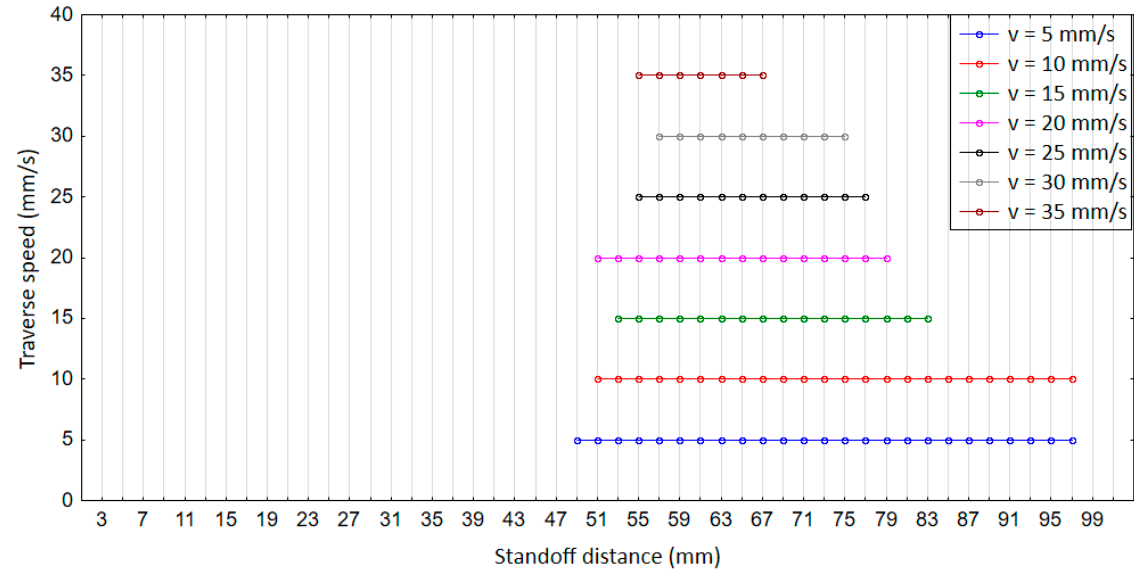
Figure 5. Effect of the PWJ at constant pressure with variation in standoff distance ( z = 5 to 101 mm) and traverse speed ( v = 5 to 35 mm/s).